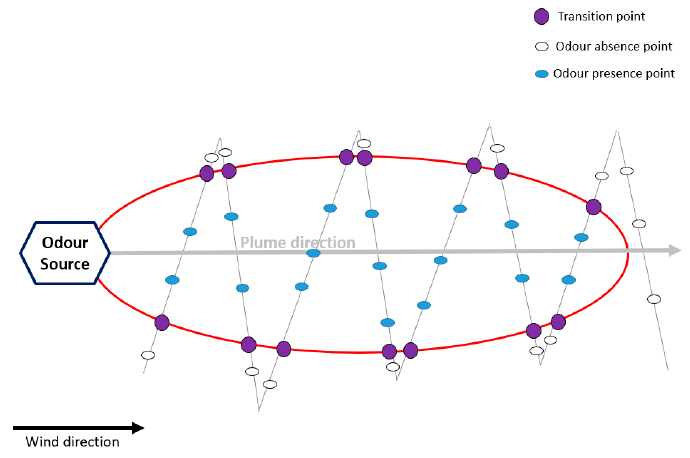
Figure 9. Stationary plume method—field inspection.